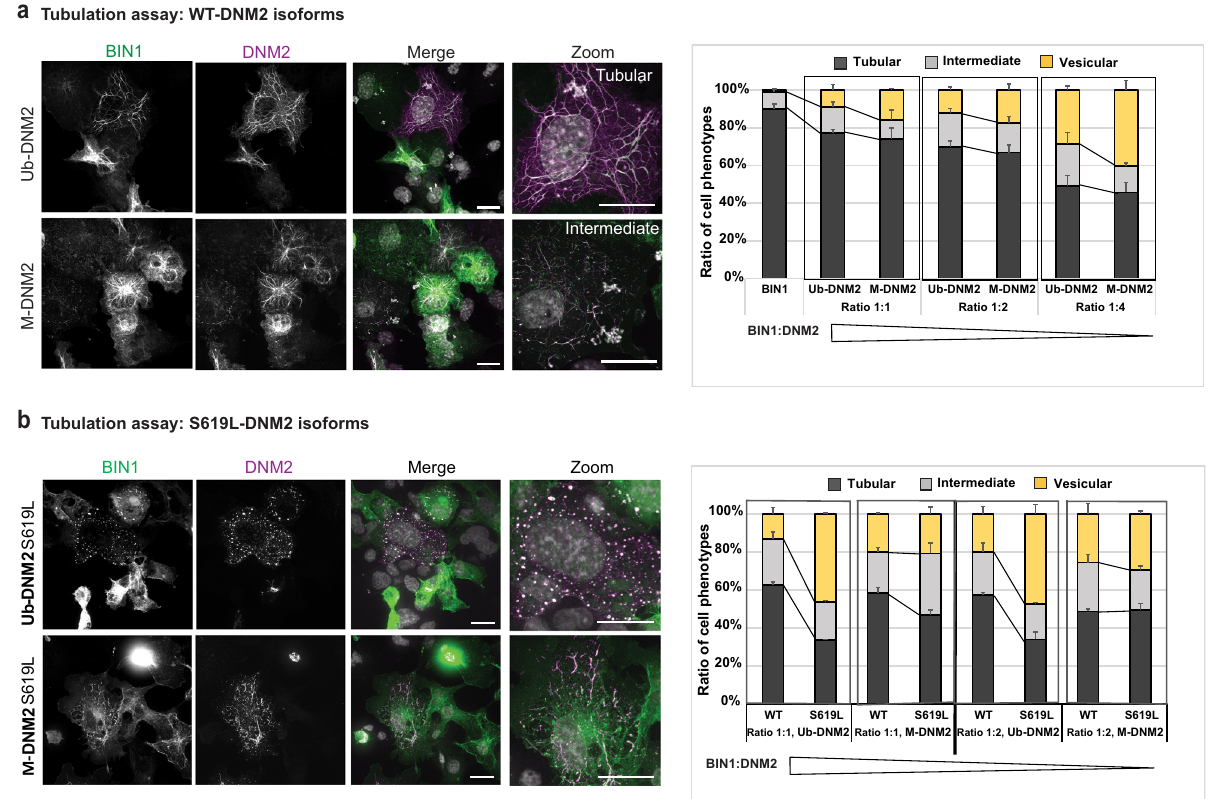
Fig. 8 | Differential membrane fi ssion activity of DNM2 isoforms. a Fission activity in cellulo where BIN1-eGFP (green) and WT-DNM2 (magenta), M-DNM2 or Ub-DNM2, were co-expressed in COS-1 cells at incremental DNM2 concentration. Scale bar=20 µ m. b Fission activity in cellulo done as ( a ) co-expressing BIN1-eGFP (green) and the CNM mutant S619L-DNM2 (magenta). Scale bar=20 µ m. In both fi gures( a , b ),percentageofeachcellphenotype(tubular,intermediateorvesicular